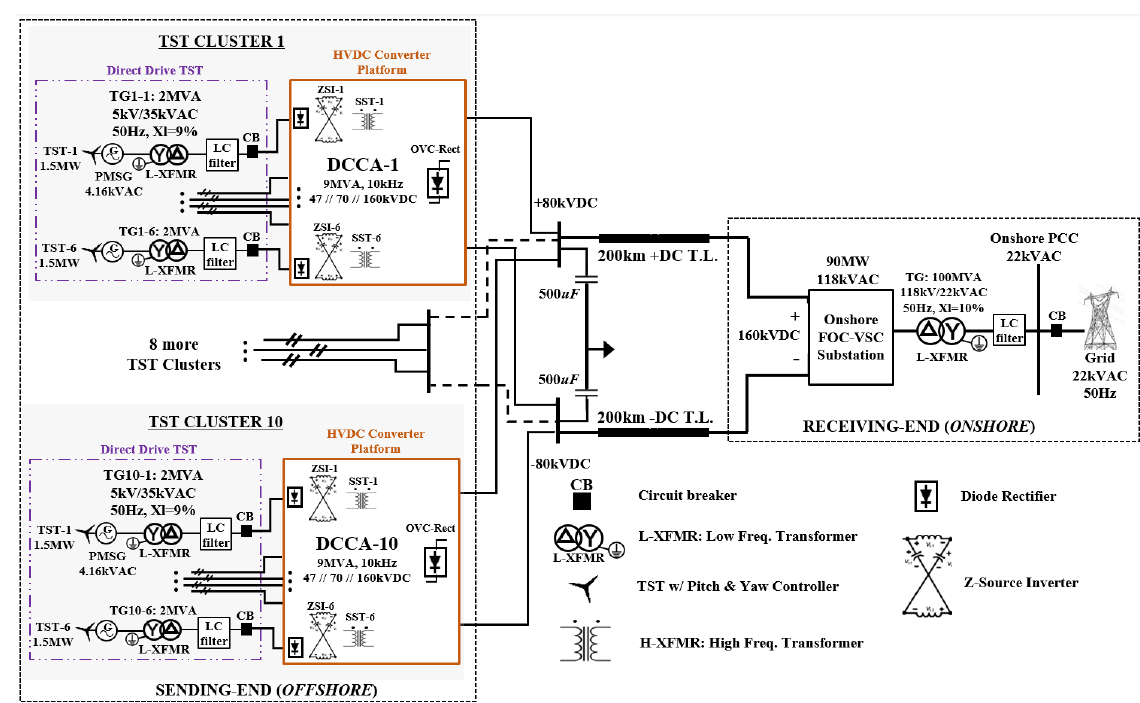
Figure 1. Proposed HVDC transmission testbed system for a 90 MW offshore tidal stream